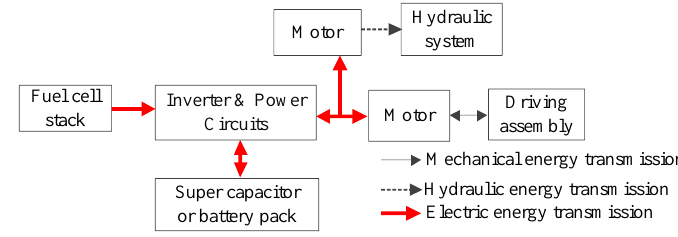
Figure 9. Typical configuration of fuel cell hybrid system [49–51].